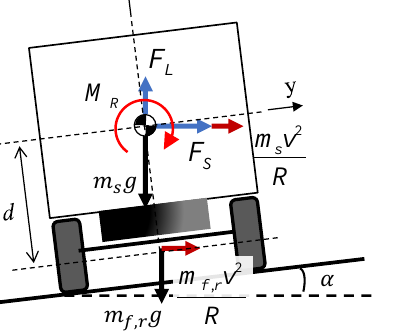
Figure 4. External forces acting on the vehicle on a curved road with a cant.